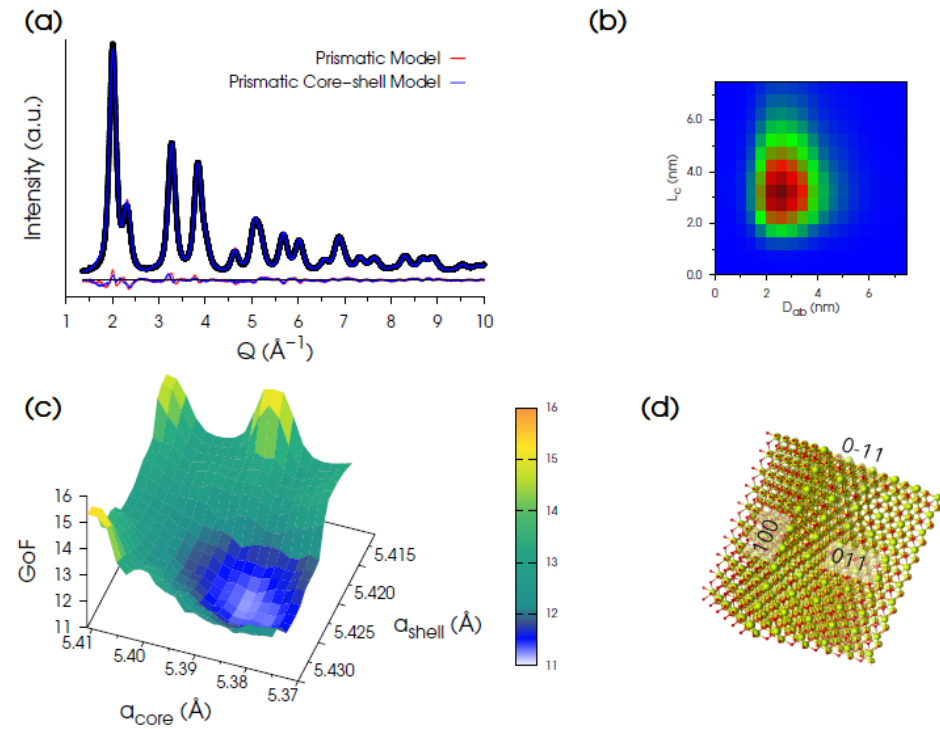
Figure 3. ( a ) Synchrotron XRPD data (black dots) of Ce200 and DSE best fits obtained using either a prismatic model (shown in panel ( d )) with a uniform unit cell parameter (red trace, GoF = 12.35) or an optimized homo core-shell prismatic model (blue line, GoF = 10.94). ( b ) 2D map of the refined bivariate lognormal size distribution function of NCs in the L c and D ab coordinates (D ab is the diameter of equivalent volume to the prism basal plane). ( c ) 3D hypersurface of GoF versus a core and a shell explored for the optimization of the homo core-shell prismatic model. ( d ) Prismatic model of CeO 2 NCs exposing {011} and {100} facets.